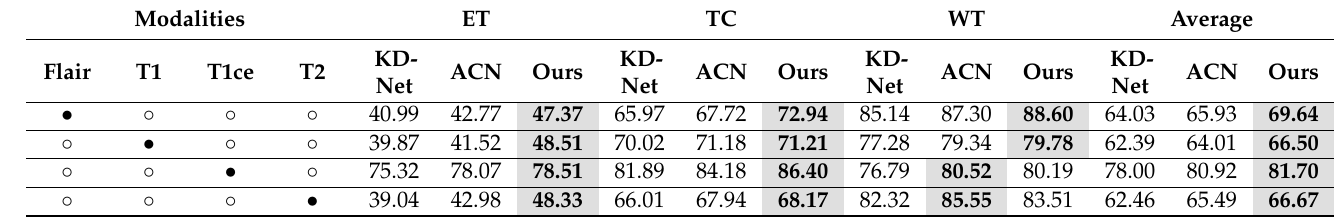
Table 2. Comparison of the proposed method with the knowledge distillation framework KD-Net [25] and the state-of-the-art method ACN [35] (DSC%).